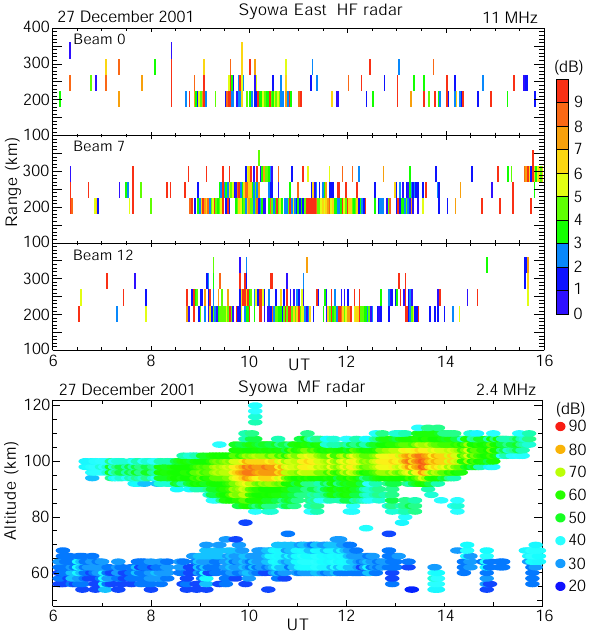
Fig. 7. Time and range variations of echo power observed (upper) on beams 0, 7, and 12 of the Syowa East HF radar (11MHz) and (lower) with the Syowa MF radar on 27 December 2001.